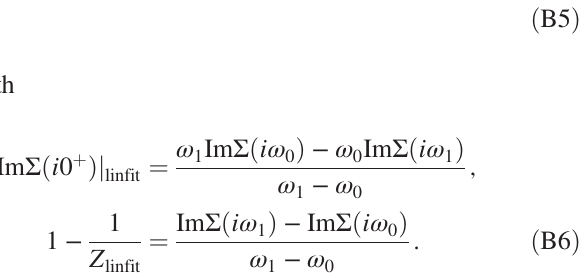
FIG. 28. Imaginary (negative) part of the local self-energy extrapolated to zero Matsubara frequency as a function of temperature calculated in DiagMC (black circles), DMFT (blue squares), and D Γ A (red